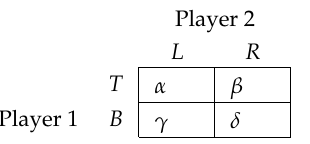
Figure 2. Probability distribution p t